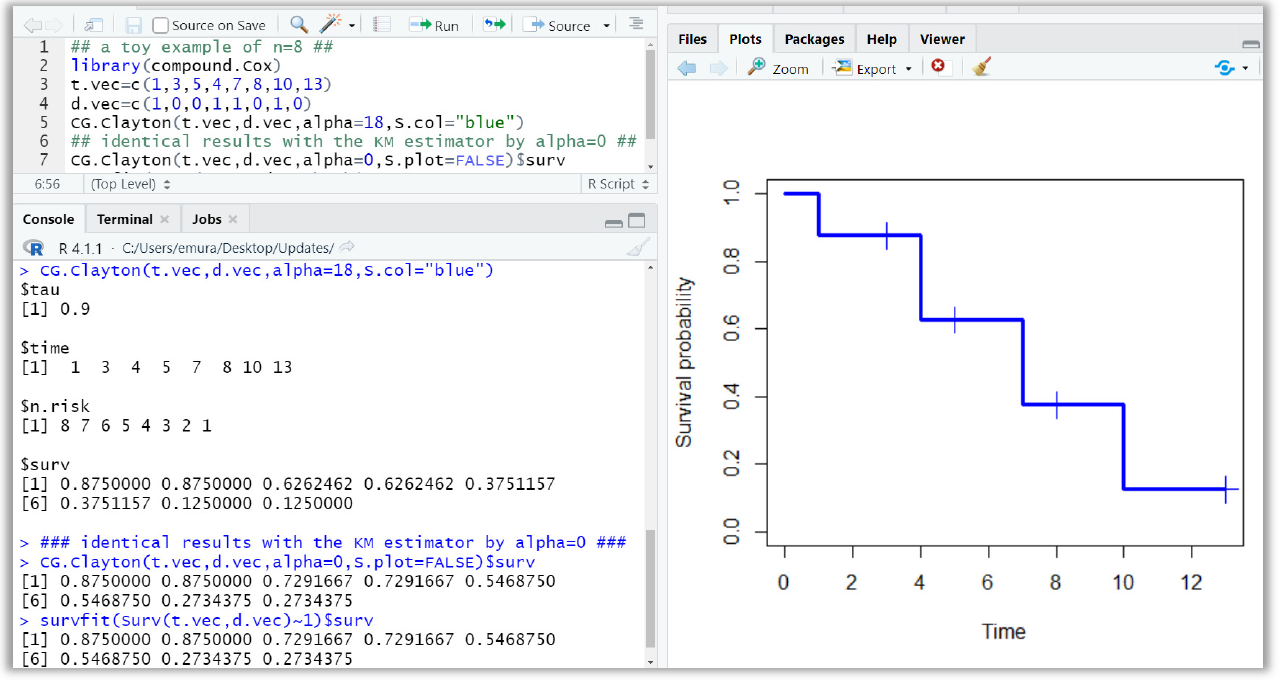
Figure 2. The R console showing an example of the CG estimator under the Clayton copula. The upper-left panel is the R code. The right panel is the plot of the Clayton CG estimates computed by data t i = 1, 3, 5, 4, 7, 8, 10, 13; δ i = 1, 0, 0, 1, 0, 1, 0. The lower-left panel shows the numerical values of the estimates (survival probabilities). The Clayton copula’s parameter is specified as α = 18 (Kendall’s tau is 0.9). If one specifies the copula parameter as α = 0, this yields the KM estimator. We see that the numerical results are identical to the results computed by the survfit(.) function (lower-left panel).